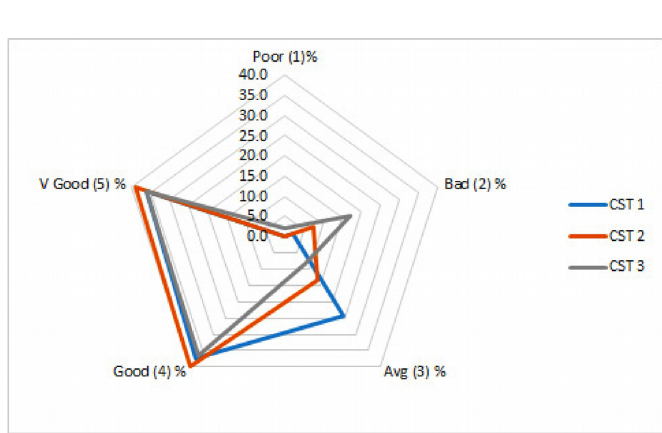
Figure 3. Radar diagram on cost